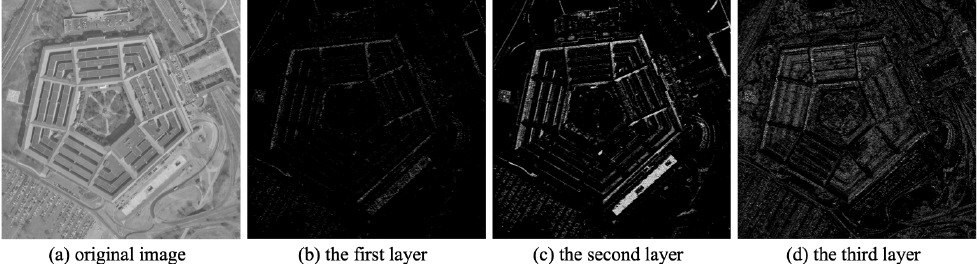
Figure 6. The segmentation results of image